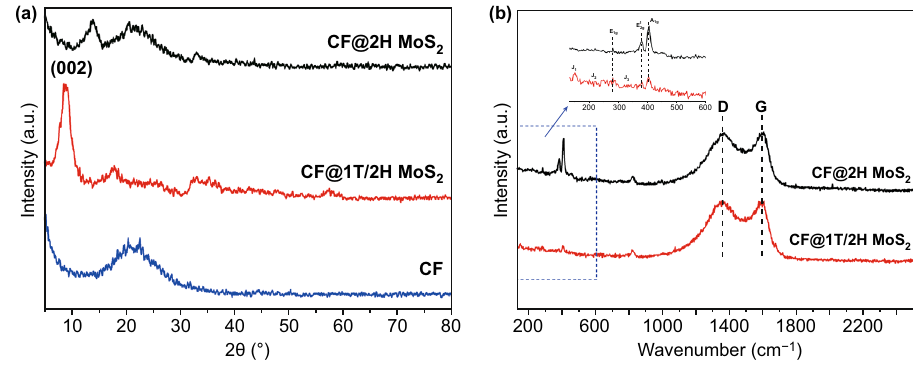
Fig. 3 a XRD patterns, b Raman spectroscopy of CF@1T/2H MoS 2 and CF@2H MoS